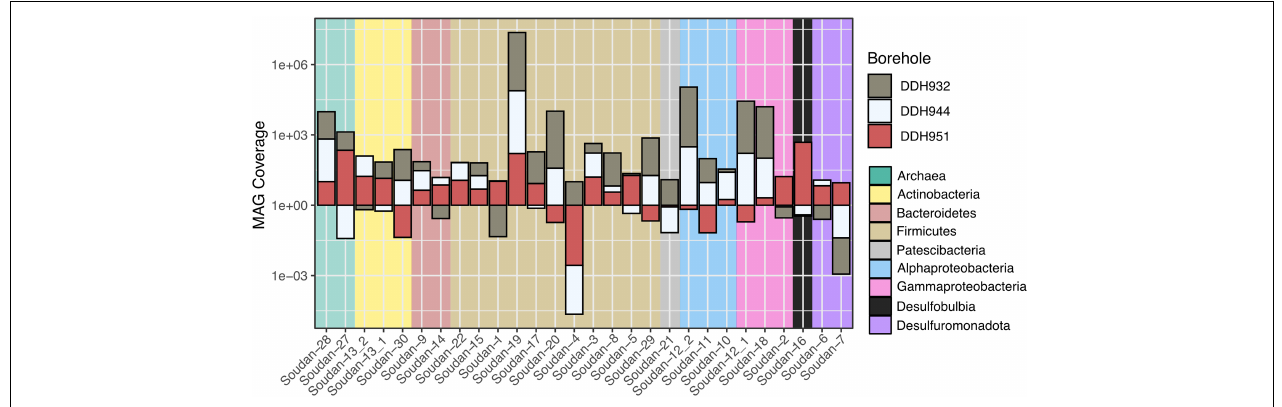
FIGURE 3 | Taxonomy and coverage of Metagenome Assembled Genomes (MAGs) recovered from Soudan metagenomes. Bars below one represents rare to nearly absent